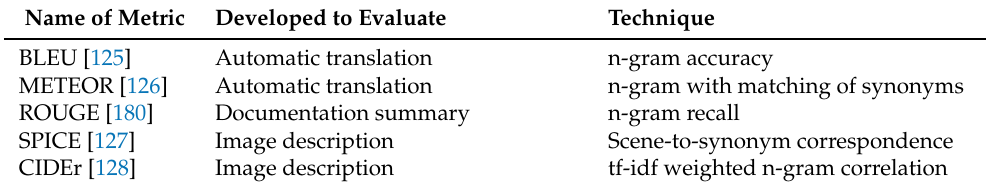
Table 5. An overview of the assessment metrics taken into account for this research